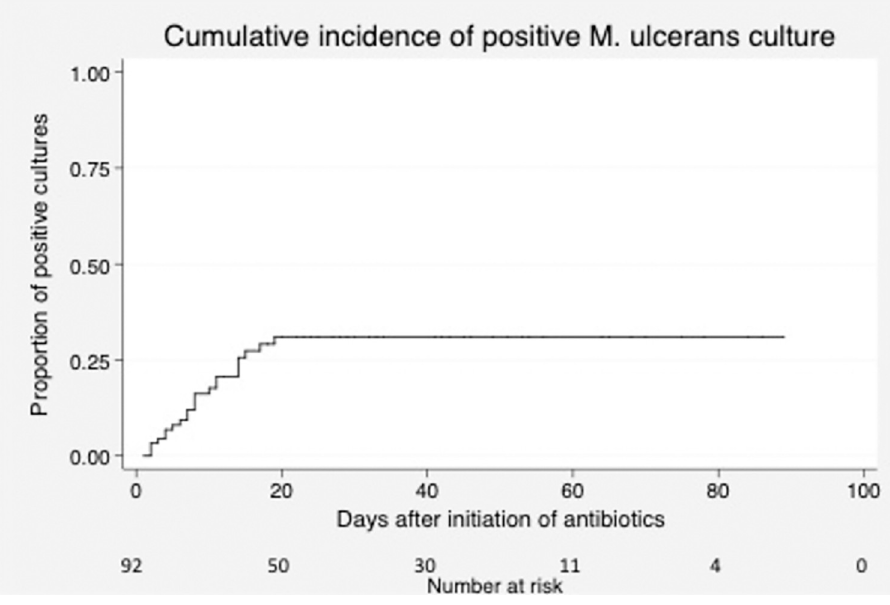
Fig 2. Kaplan-Meier curve showing the cumulative incidence of positive M . ulcerans cultures according to days of antibiotic treatment.